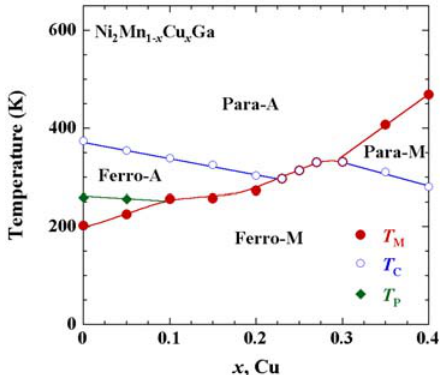
Figure 2. Phase diagram of Ni